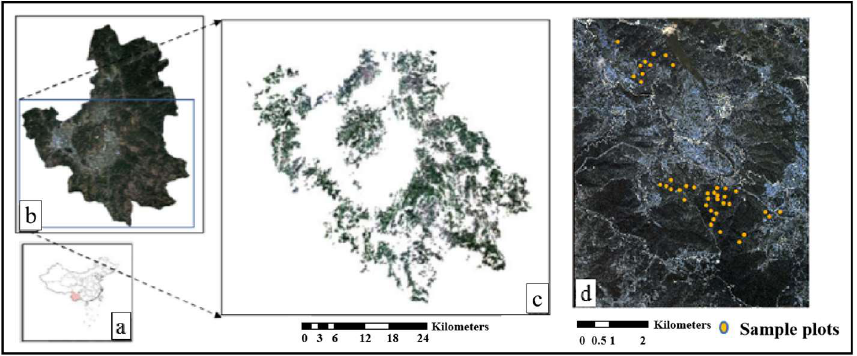
Figure 1. ( a ) Yunnan province in China; ( b ) Landsat image of Xiangyun County; and ( c ) Yunnan pine forests in the study area. ( d ) Distribution of the 40 field plots in the study area.